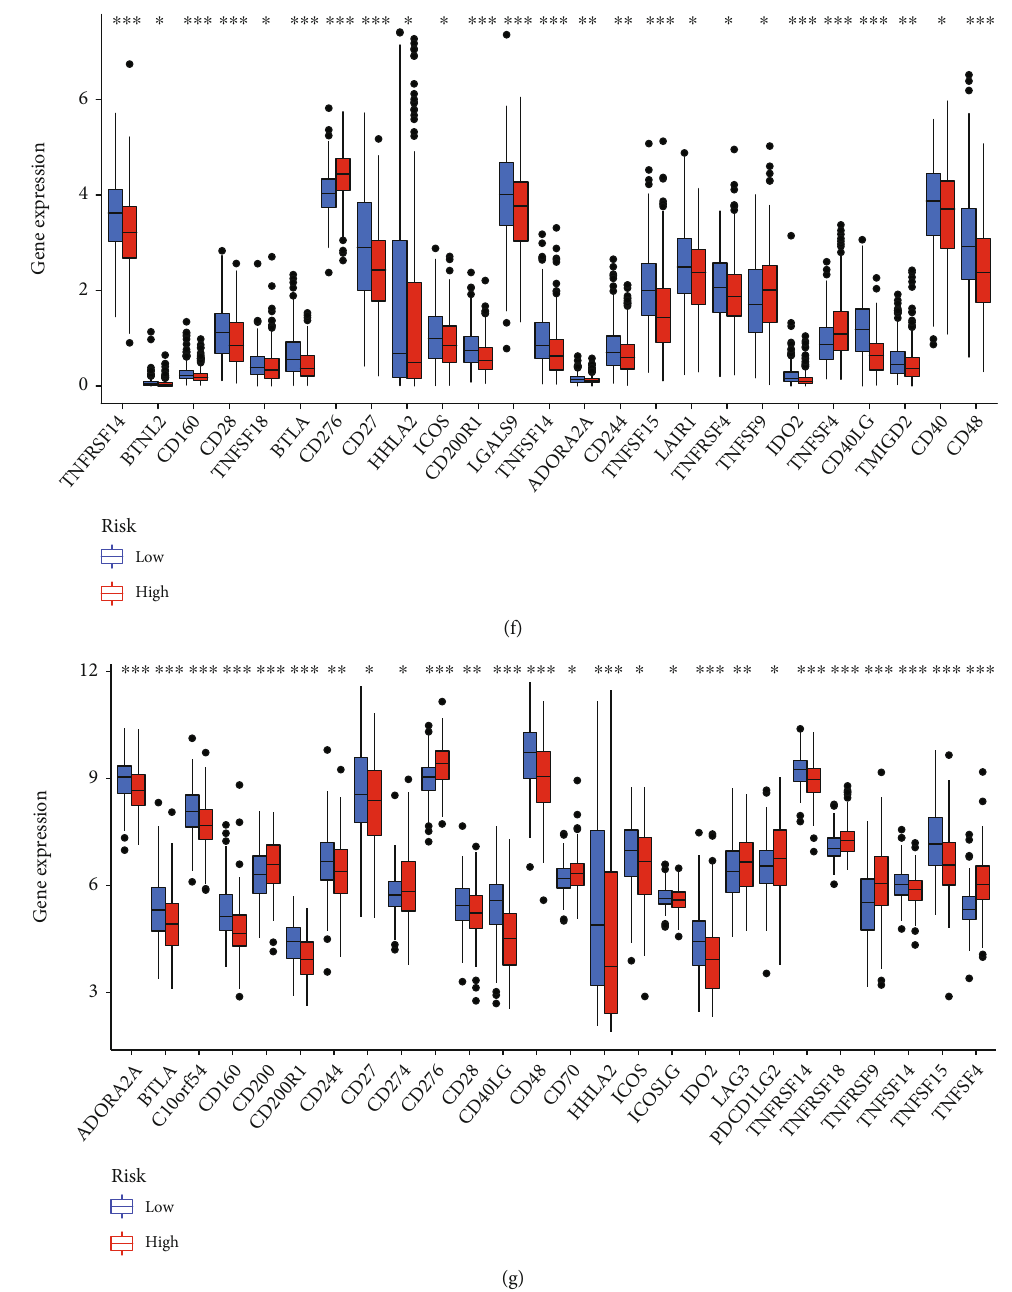
Figure 4: Immunity correlation analysis. (a) ESTIMATE score of immune cells. (b) ESTIMATE score of stromal cells. (c) TIDE score. (d) Abundance of immune cells in TCGA-LUAD cohort. (e) In fi ltration score of immune cells in GSE72094. (f) Expression of immune checkpoints in TCGA-LUAD cohort. (g) Expression of immune checkpoints in